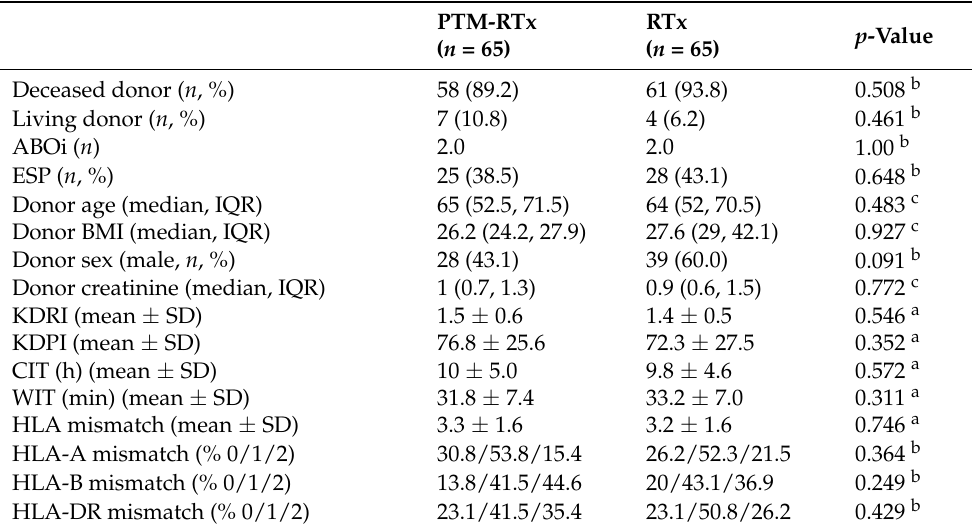
Table 3. Baseline donor characteristics for renal transplantation recipients with and without a pretransplant malignancy, matched by age, sex and underlying end stage renal